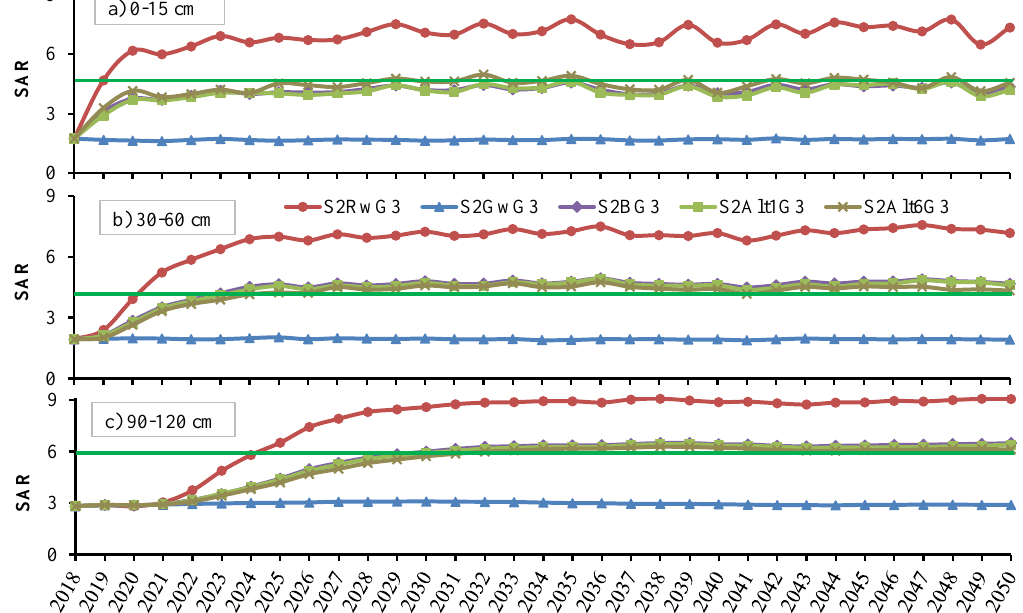
Figure 10. Impact of different water qualities (recycled water, RW; good water, GW; blending of RW and GW in a 1:1 ratio, B; RW and GW used in monthly cycles, Alt1; and RW and GW used half-yearly cycles, Alt6) and annual gypsum applications of 8.6 t/ha (G3) on annual SAR for hard red-brown soil (S2) under almond cultivation.